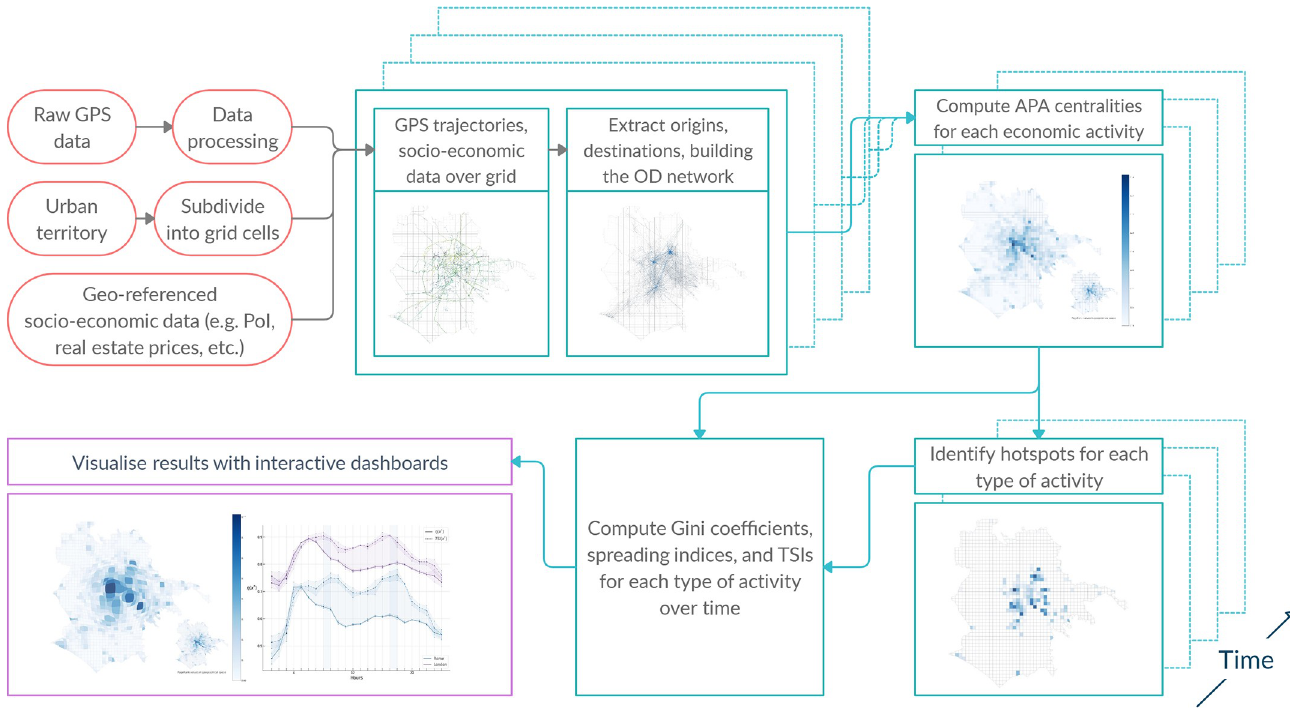
Fig 3. Flowchart of the